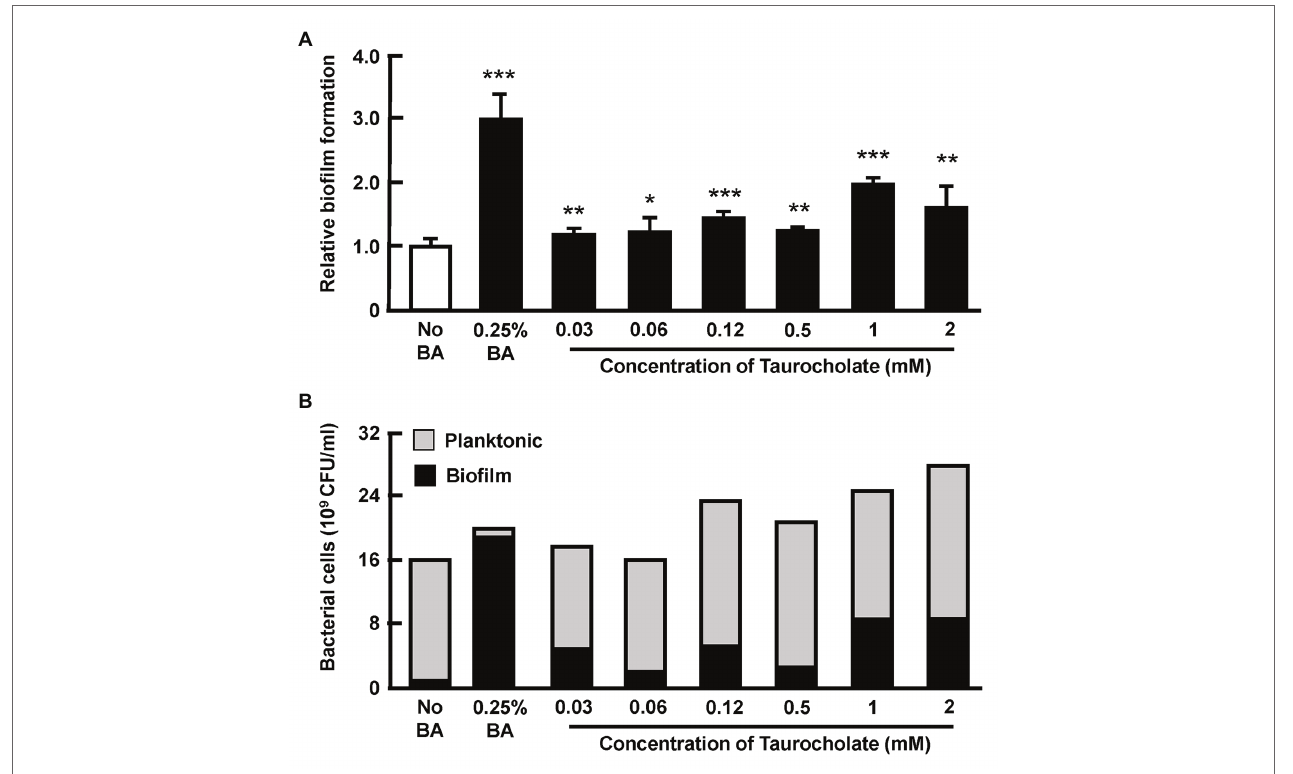
FIGURE 7 | Taurocholate increased the number of both biofilm and planktonic AHPND-causing V. parahaemolyticus 5HP in culture supernatant. Effect of taurocholate on the number of planktonic bacterial cells was assessed by treating the AHPND-causing V. parahaemolyticus 5HP with crude bile acids and taurocholate. (A) Biofilm formation in the presence of taurocholate.The data represent fold change compared to no-bile-acid control. Each bar represents mean ± SD. The statistically significant differences between the treatment groups and the no-bile-acid control group are indicated as asterisks (Student’s t- test, * p < 0.05, ** p < 0.01, and *** p < 0.001). (B) Proportion of planktonic and biofilm